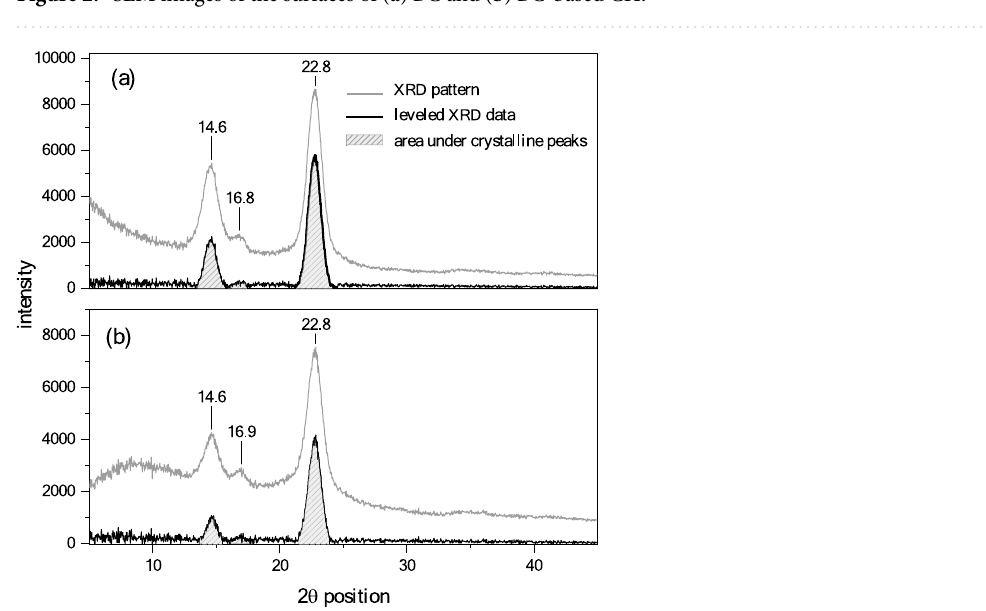
Figure 2. SEM images of the surfaces of ( a ) BC and ( b ) BC-based CH.